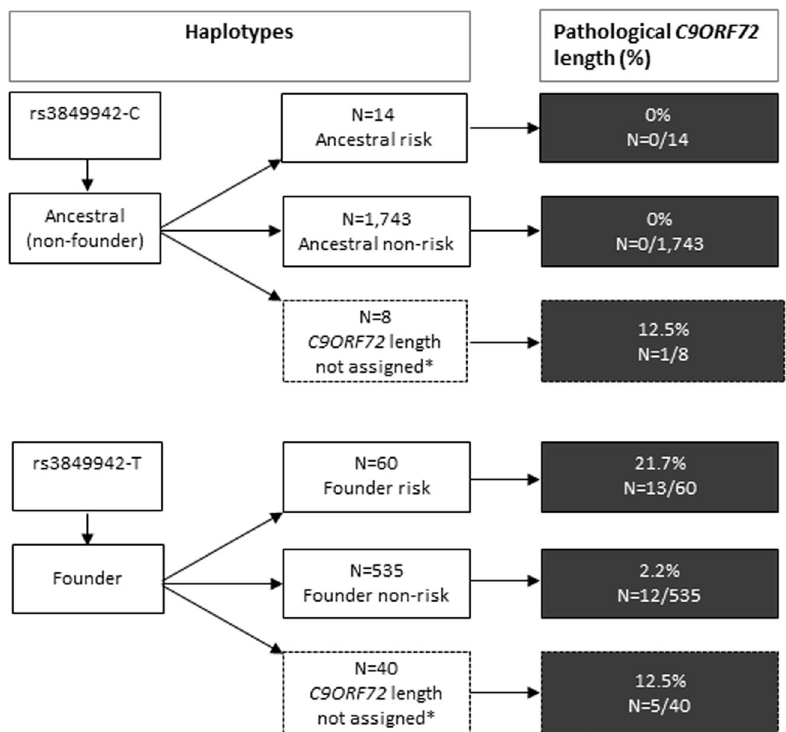
Fig. 2 Pathological C9ORF72 repeat lengths in C9ORF72 haplotypes, including ancestral non-risk haplotypes, ancestral risk haplotypes, and founder non-risk haplotypes and founder risk haplotypes. Haplotypes could be mapped to C9ORF72 repeat lengths for N = 1743 ancestral (non-founder) non-risk haplotypes, N = 14 ancestral risk haplotypes, N = 535 founder non-risk haplotypes, and N = 60 founder risk haplotypes. The founder haplotype is de fi ned by the presence of rs3849942-C (tags ancestral allele) or rs3849942-T (tags founder allele). Risk status is de fi ned by the presence of at least one risk allele, including rs117204439-C or rs147211831-A. *The subset off haplotypes that could not be assigned to C9ORF7 2 lengths had a short allele with a low probability (<0.8) for the ancestral allele (rs3849942-C) and C9ORF72 lengths differed by more than 3 repeats. Abbreviation(s) C9ORF72 : chromosome 9 open reading frame 72.